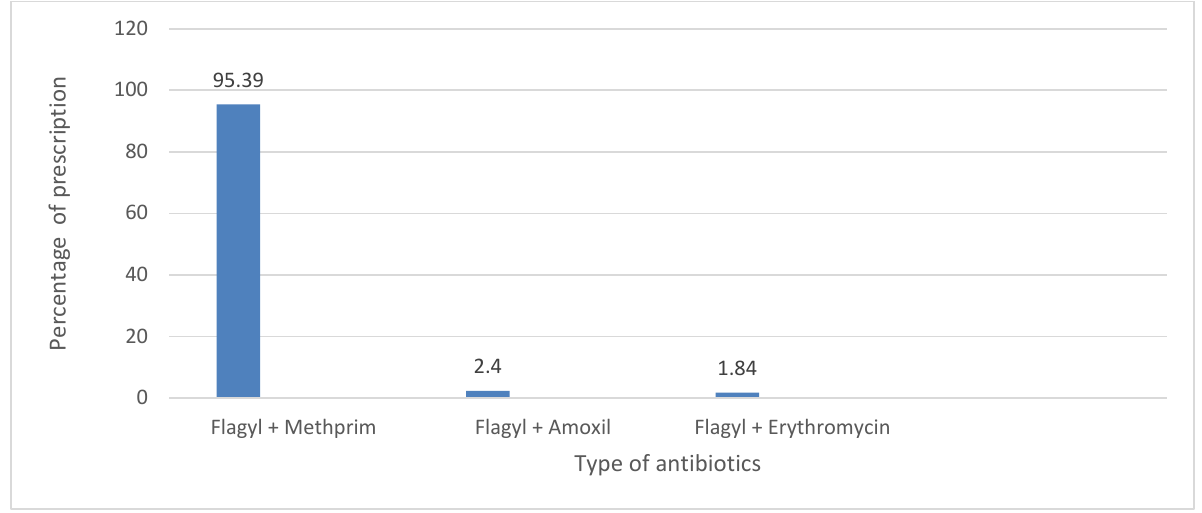
Figure 2: Double antibiotic used in outpatient department(Total 542).